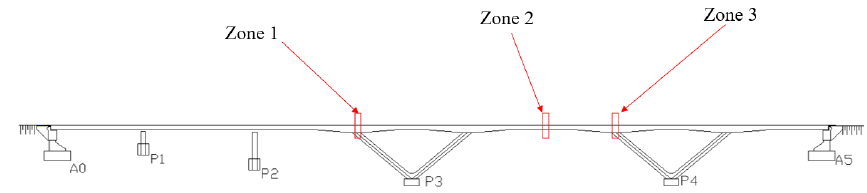
Figure 18. Different damage area settings for shear-resistant connectors.